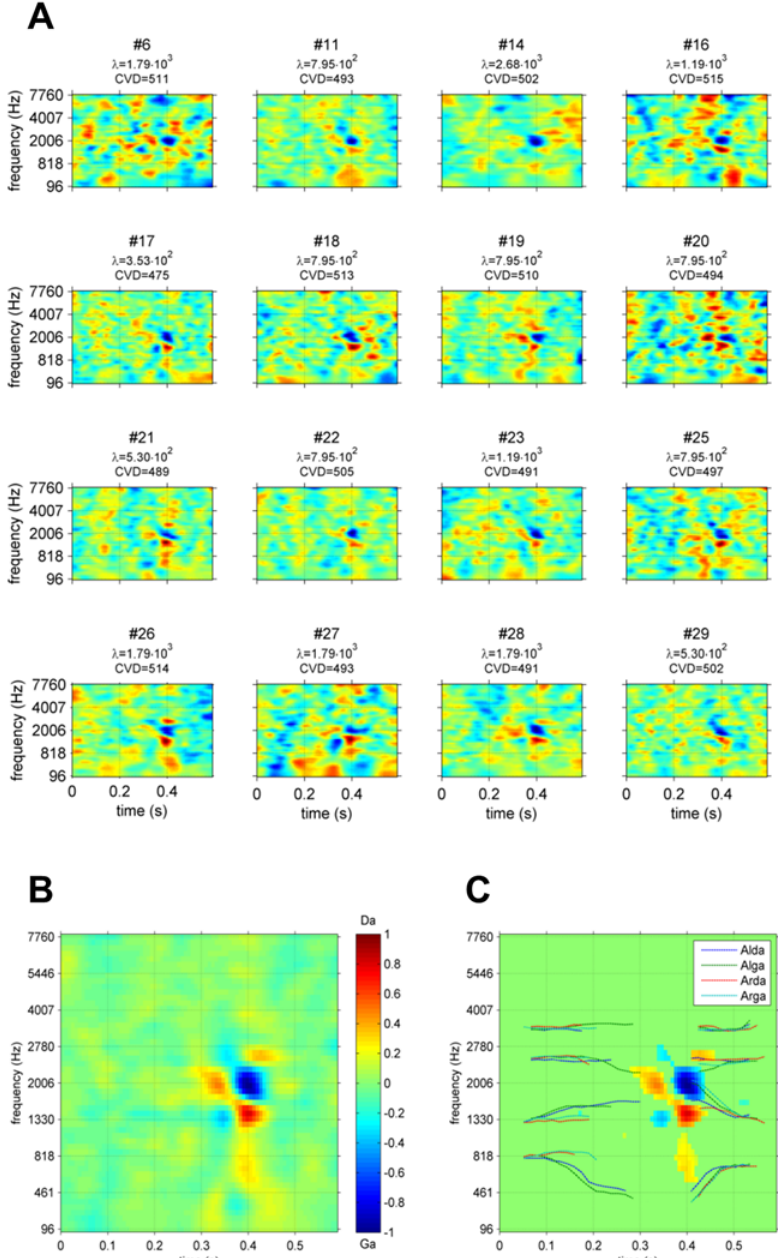
Fig 4. Global ACIs. A. Individual ACI estimated on 10,000 trials for all 16 participants. l ~ and CVD are indicated below each image. B. Mean ACI for the participants collectively (estimated with l = 1,191). C. Same ACI, with non-significant weights set to 0 (corrected t-test, FDR < 0.01) and formant trajectories superimposed. In each ACI, weights are divided by their maximum absolute